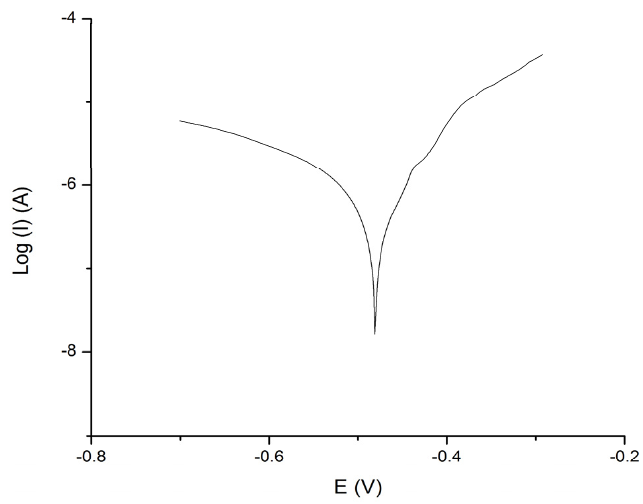
Figure 8. The polarization measurement for the validation run.